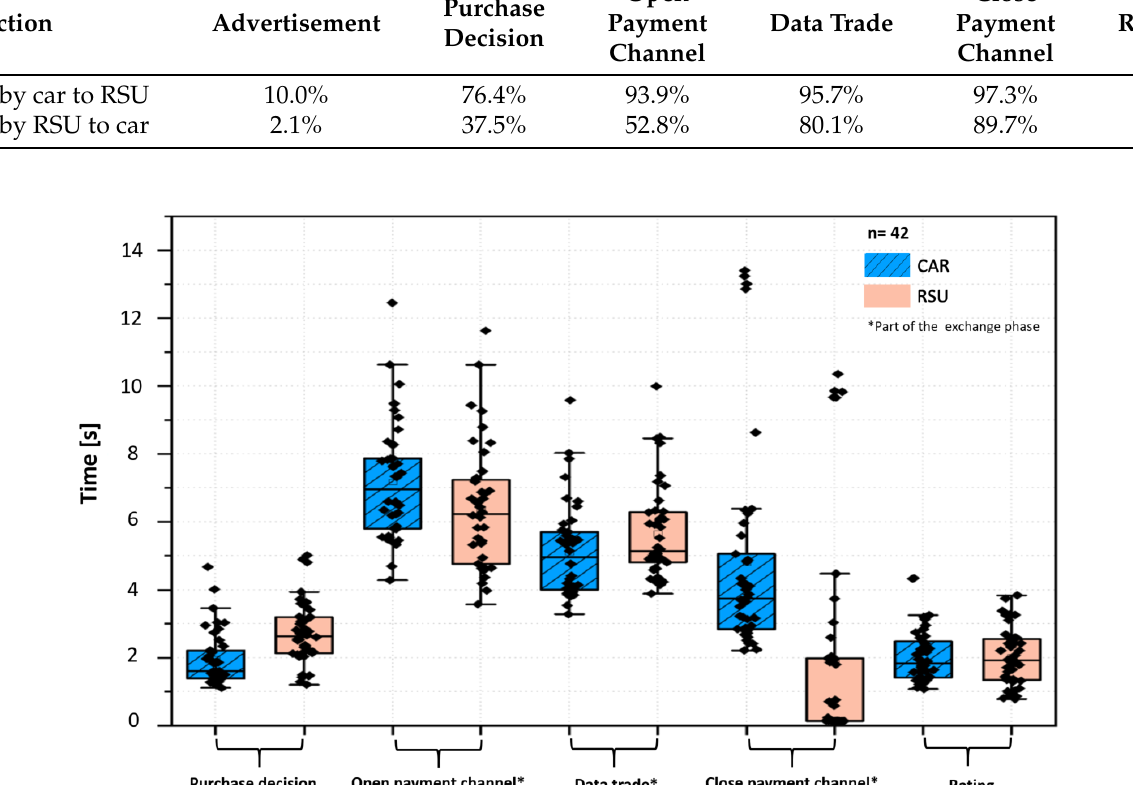
Figure 3. Communication times for all data trading phases, measured in 42 data trading sessions between a moving and stationary